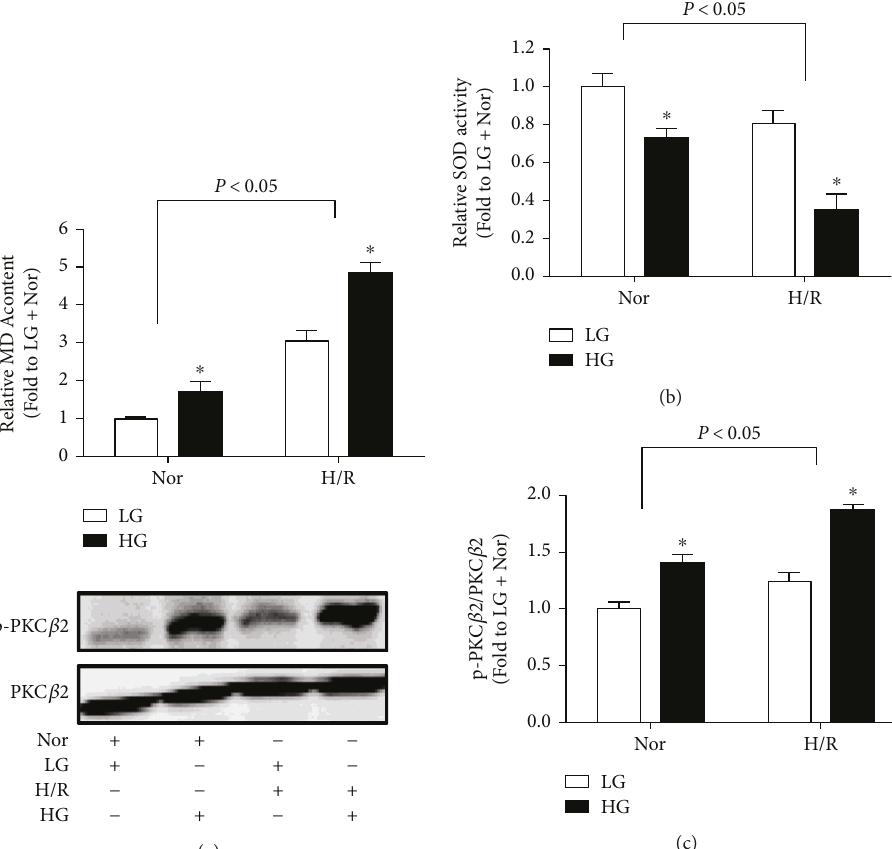
Figure 2: E ff ects of high glucose (HG) and hypoxia/reoxygenation (H/R) on MDA production (a), SOD activity (b), and PKC β 2 activation (c) in H9C2 cells. All the results are expressed as mean ± SD ( n = 8 ). Di ff erences were determined by using two-way ANOVA followed by Tukey ’ s post hoc test. ∗ P < 0 05 versus LG (low glucose) group in normoxic or hypoxic